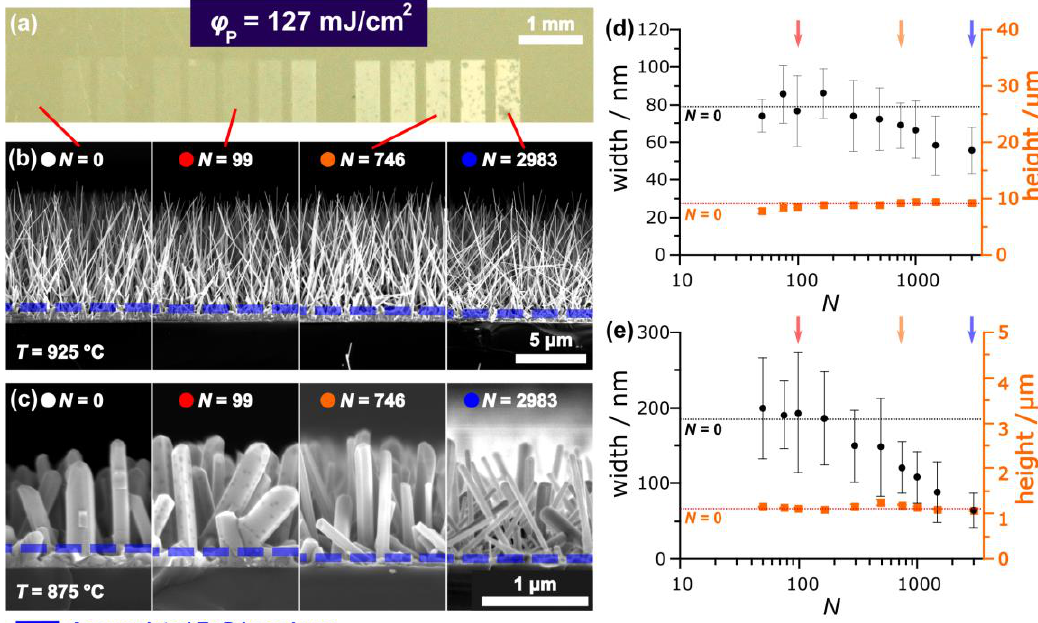
Figure 7. ( a ) Photography of a ZnO-NR covered Si-wafer compromising irradiated areas ( 𝜑 𝑝 = 127 mJ/cm 2 , t = 10 min, T = 925 °C). ( b ) Scanning electron microscopy cross-sections of the sample shown in ( a ). ( c ) Cross-sections of shorter, wider ZnO-NRs ( 𝜑 𝑝 = 127 mJ/cm 2 , t = 10 min, T = 875 °C) showing the same trend of thinning upon increasing N . d,e) Width (black) and height (orange) of ZnO-nanorods shown in ( b ) respectively ( c ). The dashed lines in ( d , e ) represent ZnO-NR grown on unirradiated areas ( N = 0).